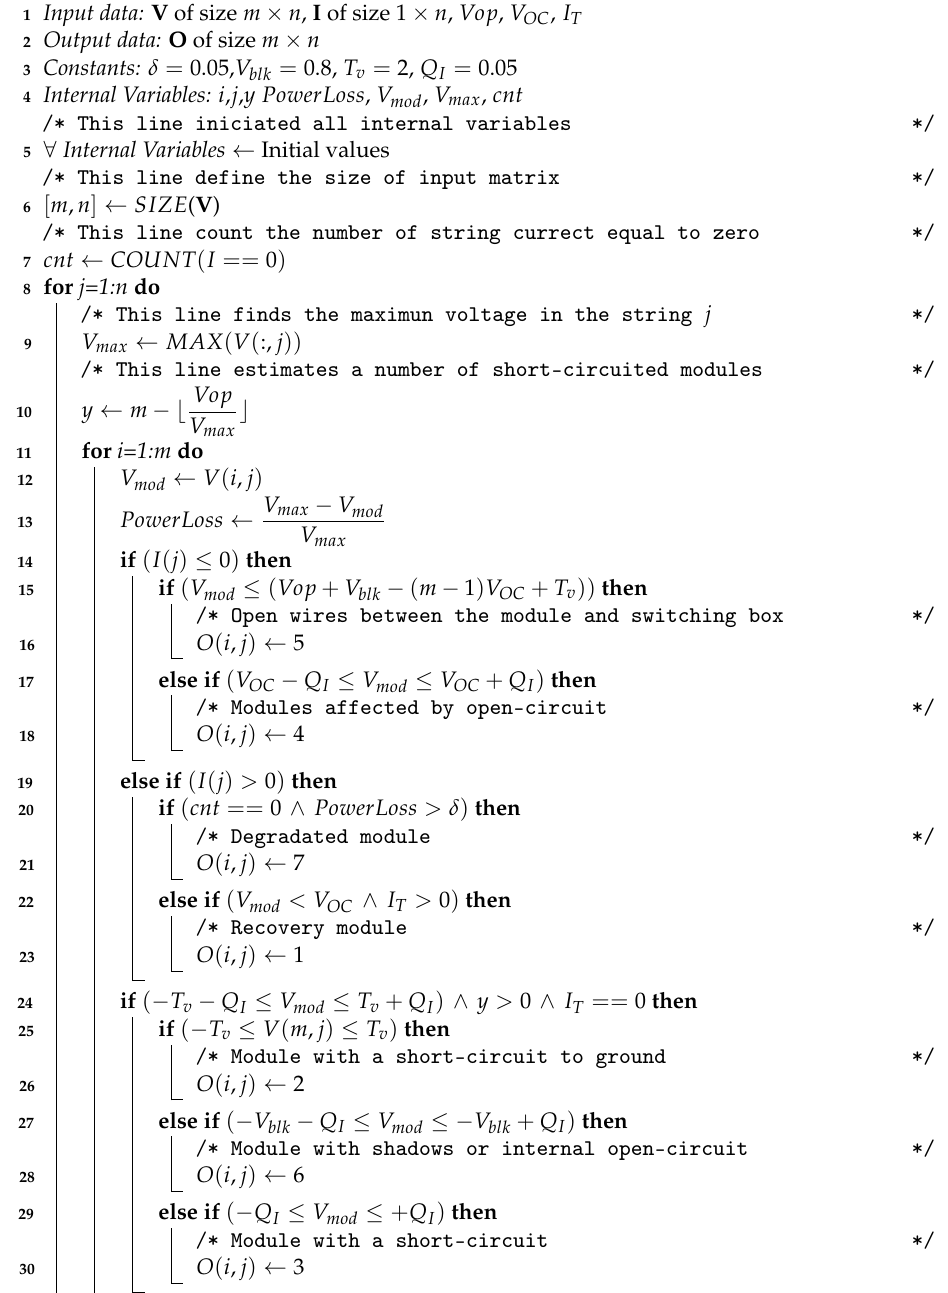
Algorithm 1: Diagnosis algorithm based on electrical